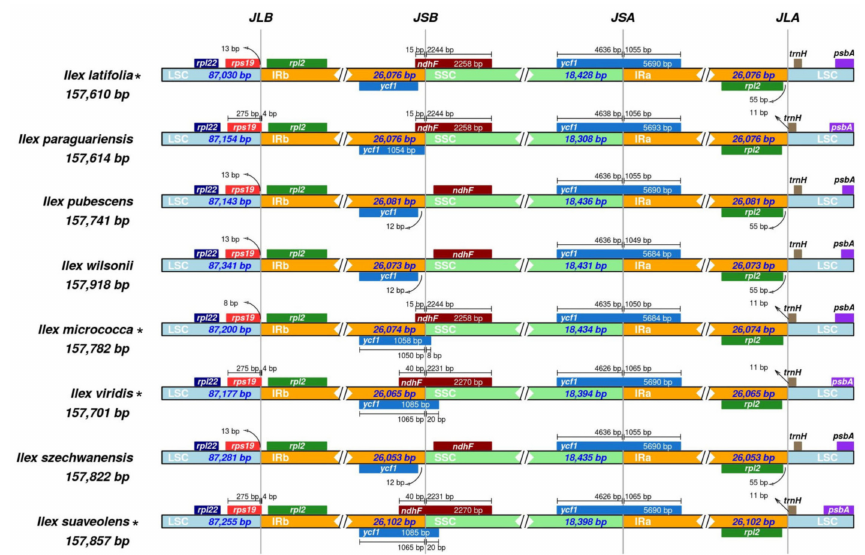
Figure 5. Comparative analyses of the junctions for the SSC / IRs and LSC / IRs regions among eight Ilex plastomes. The colored boxes above the strip scaled with sequence length indicate the denoted genes. The gaps in base length (bp) are indicated between boxed genes and boundaries. JLA, the junction of IRa / LSC; JLB, the junction of IRb / LSC; JSA, the junction of IRa / SSC; JSB, the junction of IRb /